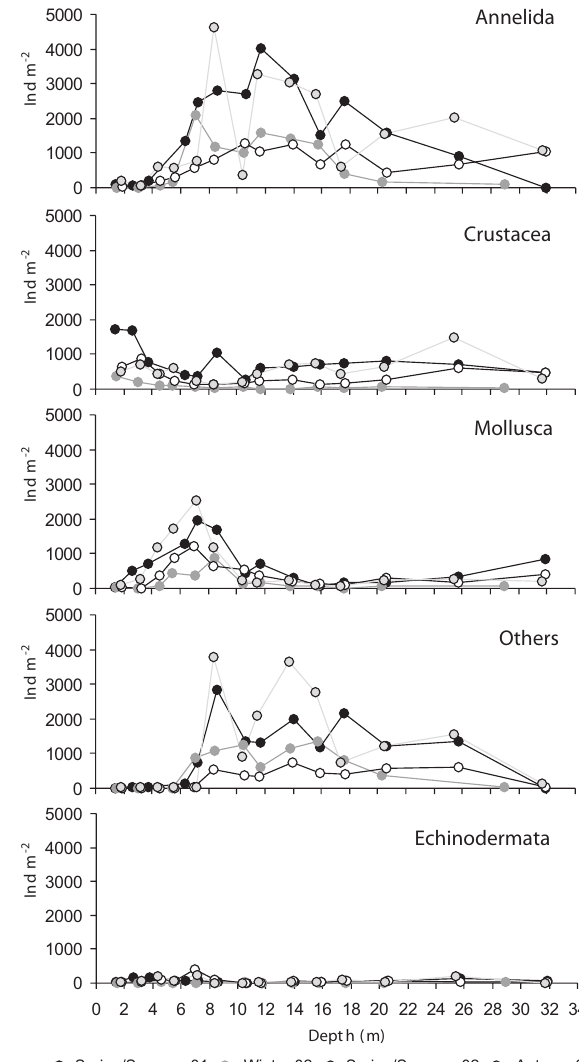
Fig. 3 . – Density variation of the main taxa along the depth gradi- ent, for the main seasons: spring/summer 01 and 02, winter 02 and autumn 02. others is composed of nemertea, Phascolion strombus , Branchiostoma